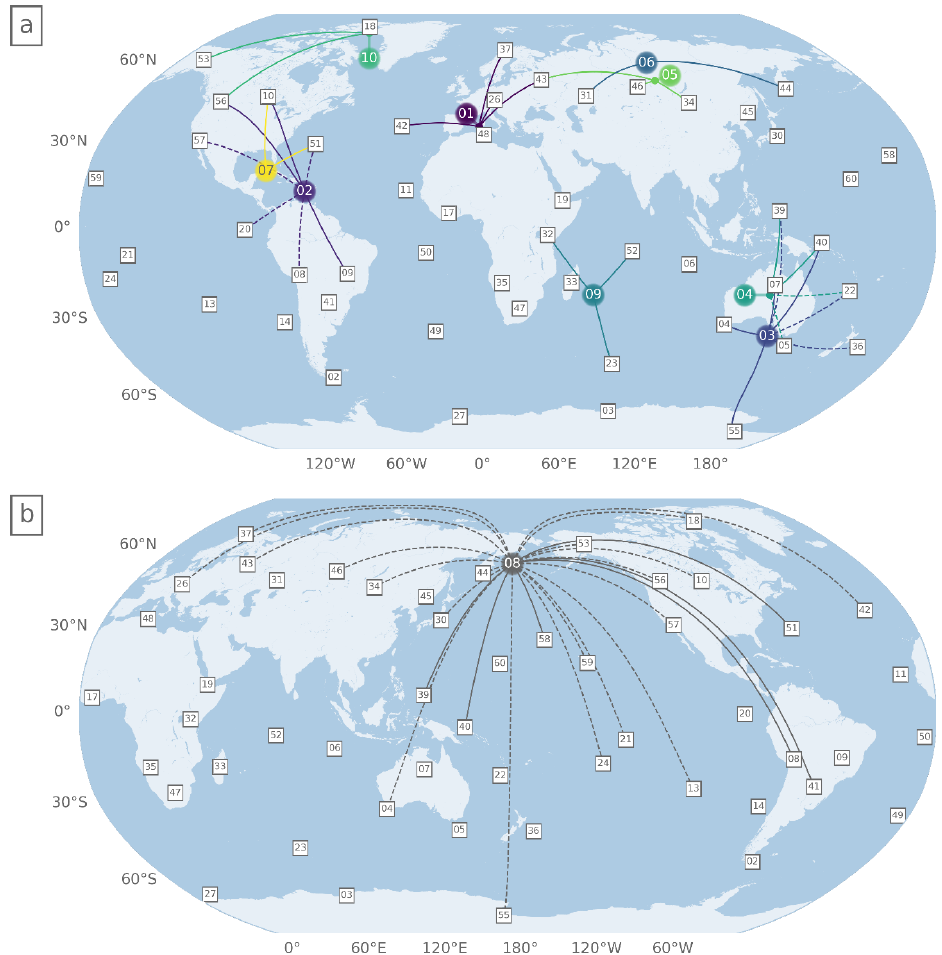
Figure 2. Location of the 10 studied fireball events, numbered 01 to 10 in colored circles from the most recent to the oldest date. The positions of certified IMS infrasound stations are provided by numbered rectangles. Stations and fireball events are connected by event-colored lines if infrasound from an event was recorded at the respective station; the line is dashed, if the detection is also part of the Reviewed Event Bulletin (REB). Nine cases are shown in map ( a ), while the Bering Sea event with world-wide detections ranging to 15,000 km is shown in map ( b ). A number of IMS stations were identified for each event that detected signatures related to the respective fireball. The PMCC method was applied to the IMS arrays’ differential pressure data to derive azimuth, apparent velocity, time, and frequency information and to associate the given signatures to the respective fireball. These parameters allow event localization and yield estimation purely based on infrasound data.